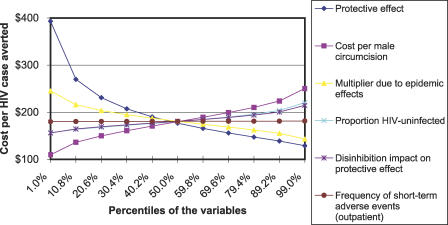
One-Way Sensitivity Analyses of the Cost per HIA Unadjusted for Anticipated Averted HIV Treatment ExpendituresFor each of the varied input values, results correspond to the ranges shown in Table 1. The 50th percentil corresponds with the base case. Similarly, the first and 99th percentiles approximate the low and high end of the ranges shown in Table 1, respectively. For example, the high-end cost per male circumcision is $82 (Table 1), which corresponds to the 99th percentile of the range, or $250 per HIA. This figure indicates that the unadjusted cost per HIA is most sensitive to uncertainty in the MC protective effect, cost per MC, and epidemic multiplier.